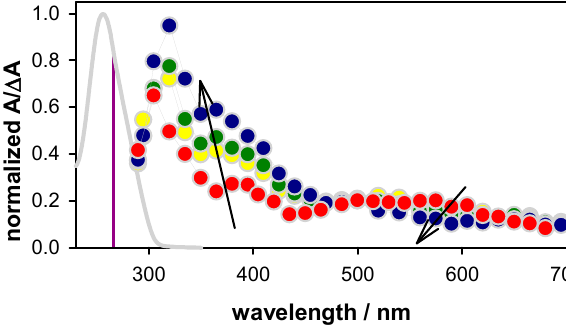
Figure 3. Transient absorption spectra determined for aerated solutions of TEL21 / K + (circles) at 3 µ s (red), 150 µ s (yellow), 1 ms (green), and 6 ms (blue). ∆ A at 500 nm was set to 0.2. The gray line corresponds to the steady-state absorption spectrum, and the vertical violet line indicates the excitation wavelength.